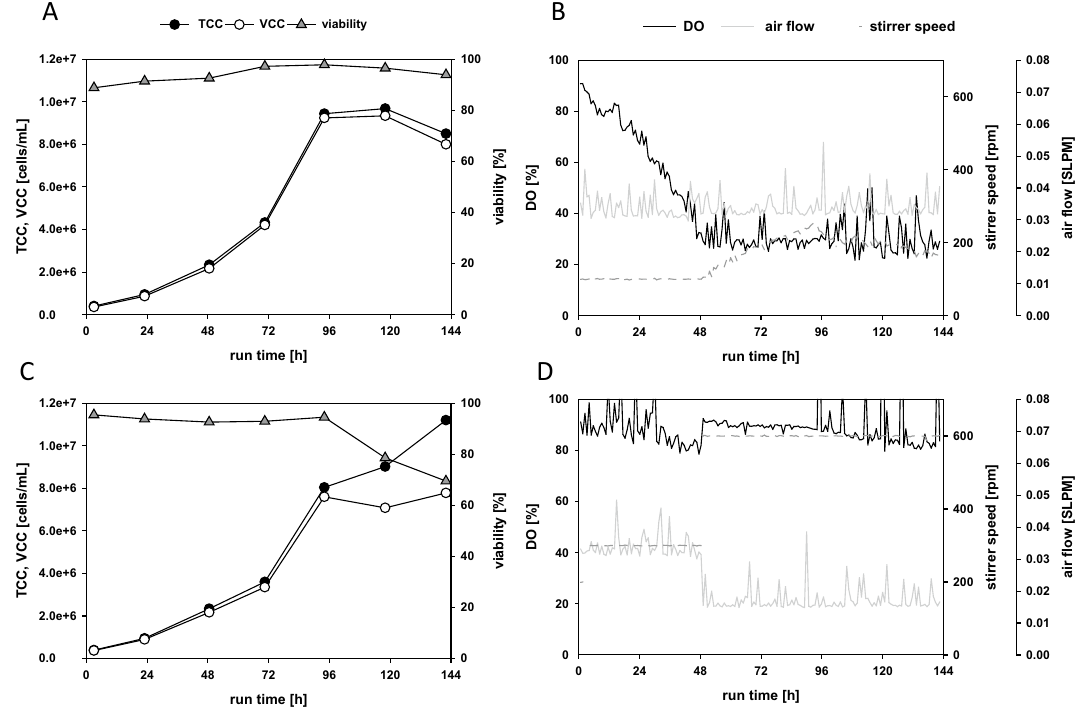
Figure 6. The impact of a high stirring speed tested by comparing two cultivations of CHO cells in microbial bioreactors, at different stirring speeds. ( A , B ) A standard batch cultivation with a low stirring speed (100 rpm); ( C , D ) a batch process with a high stirring speed (300 stepped to 600 rpm). (Left column) Viability (triangles), and counts of total cells (TCC, filled circles) and viable cells (VCC, open circles) in the batch cultivation; (right column) the corresponding dissolved oxygen (DO, black solid line), stirring speed (dotted line), and air flow (solid grey